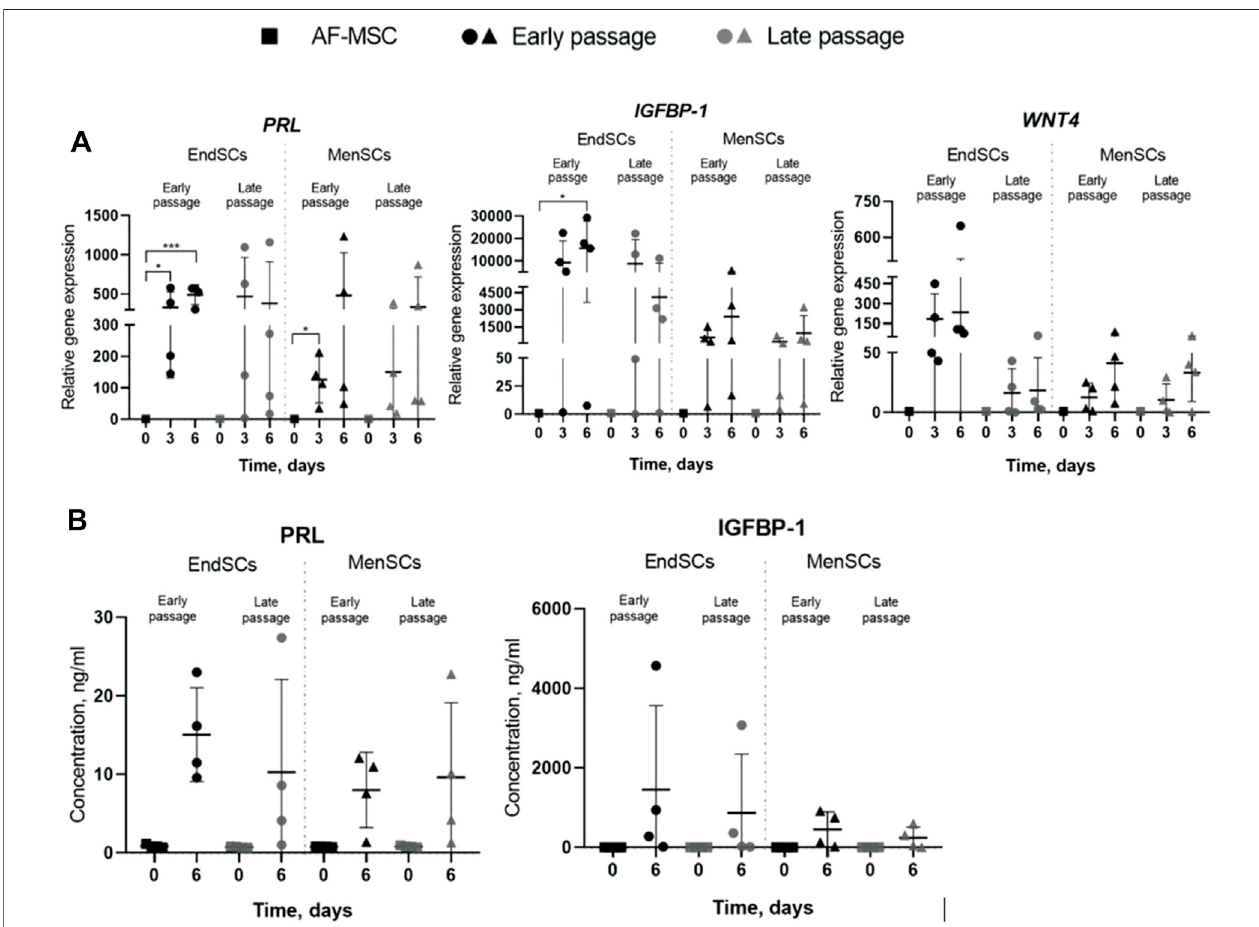
FIGURE 7 | Assessment of decidualization of EndSCs and MenSCs at gene expression level and protein level. 0d. — undifferentiated control cells, 3d. — cells after 3 days of decidualization, 6d. — cells after 6 days of decidualization. (A) relative gene expression of decidualization gene markers PRL, IGBFP-1, WNT4 genes was detected in early and late passages after 3 and 6 days of decidualization induction. Relative gene expression was measured using RT-qPCR and calculated using ΔΔ Ct method. Data were normalized to GAPDH and presented asmean ± SD ( n (cid:2) 6). (B) Concentrations ofdecidualization markers PRL and IGFBP-1 were detected in early and late passages after 6 days of decidualization induction using ELISA. Data represent mean ± SD ( n (cid:2) 4). * indicates p ≤ 0.05; ** indicates p ≤ 0.01; *** indicates p ≤ 0.001 compared to undifferentiated control. No statistically signi fi cantchangeswere detectedbetween different passages and cell groups as evaluated byone-way